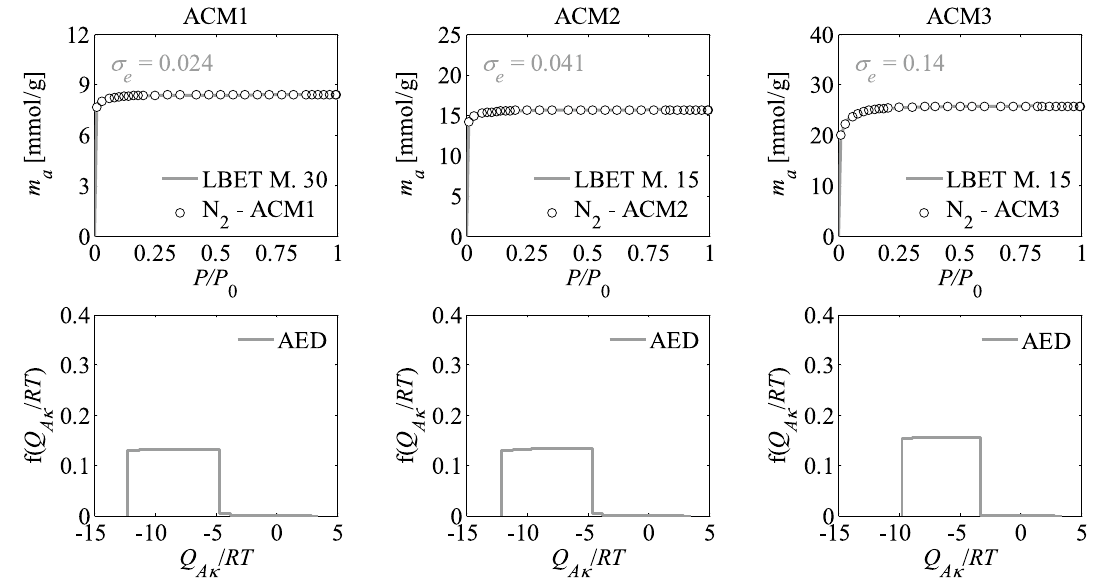
Figure 2. Nitrogen adsorption isotherms and adsorption energy distributions (AED) obtained by applying the LBET method to the experimental data for the activated carbons ACM R developed by chemical activation of Pine cones with KOH, at the middle temperature i.e. T = 973 K with the different impregnations ratios ( R = 1, 2, 3).